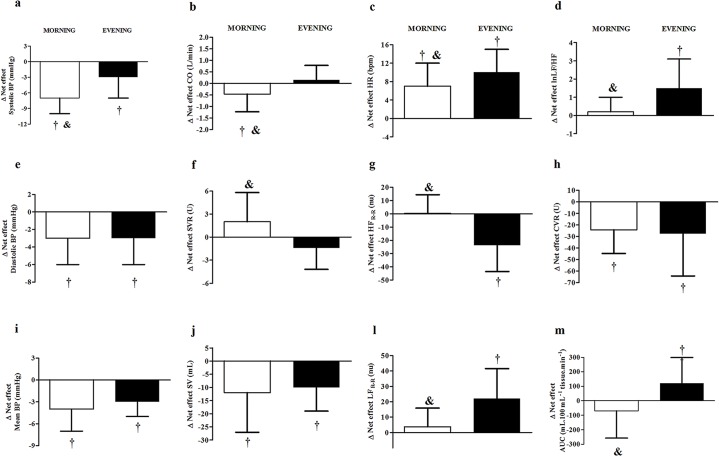
Comparison between the net effect of exercise in the morning and evening.(a) Systolic blood pressure (SBP), (b) cardiac output (CO), (c) heart rate (HR), (d) logarithmic of low to high frequency ratio of R-R interval variability (lnLF/HF), (e) diastolic blood pressure (DBP), (f) systemic vascular resistance (SVR), (g) normalized high-frequency component of R-R interval variability (HFR-R), (h) calf vascular resistance (CVR), (i) mean blood pressure (MBP), (j) stroke volume (SV), (l) normalized low-frequency component of R-R interval variability (LFR-R) and (m) calf vascular resistance (CVR) and area under the curve of calf blood flow response to reactive hyperemia (calf AUC). , , , , , , † Significant net effect (P≤0.05), & significantly different from evening net effect (P≤0.05).